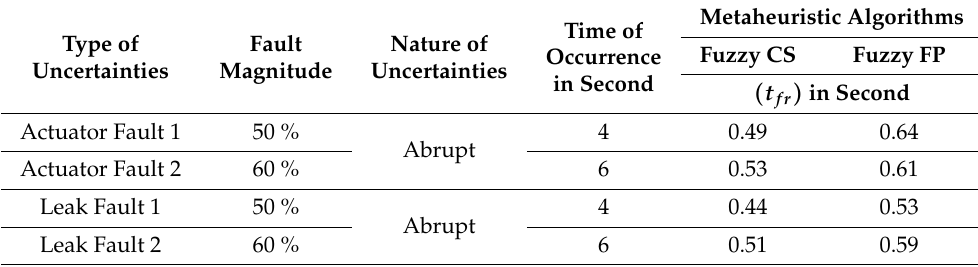
Table 8. Comparative results of fault recovery time ( t fr ) for TTCFNLC system under three uncertain- ties found by fuzzy CS and FP algorithm using